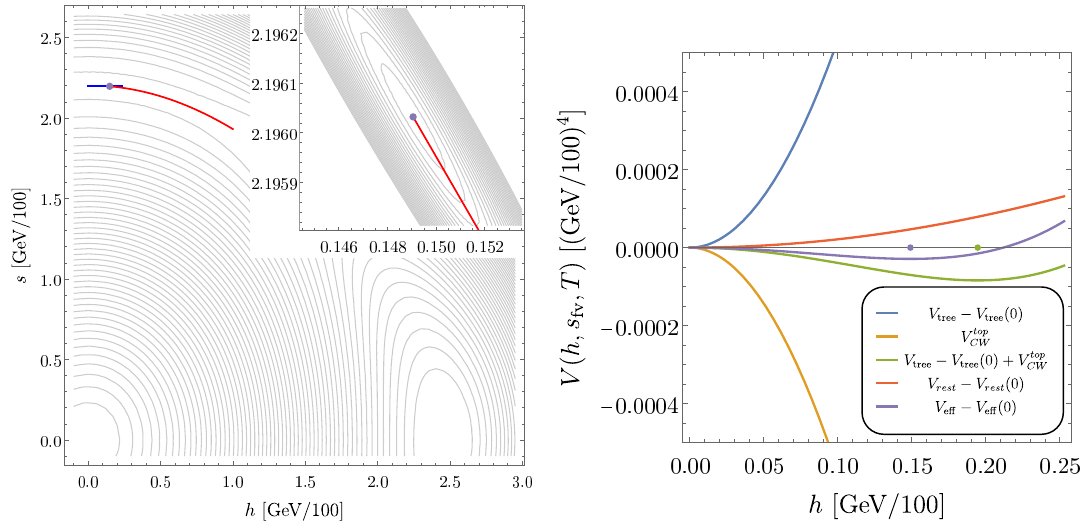
Figure 5 . Here is presented an explicit example of displacement of the false vacuum for { λ hs , v s , T } = { 0 . 36784 , 220 GeV , 3 GeV } . Left : we show the 2D potential where the blue line corresponds to the part of the potential plotted in the right panel and the (purple) dot is the po- sition of the displaced false minimum, in both the plots. Red line indicates the bounce trajectory. Right : plot of the different contributions to the potential. We see that a displaced minimum can be generated balancing the tree level and the CW potential of the top quark, for low enough temperature, in such a way all the other particles, that are massless in the false vacuum, have a negligible contribution. It can be shown that they cause, as the temperature increases, the shift of the local minimum towards h = 0